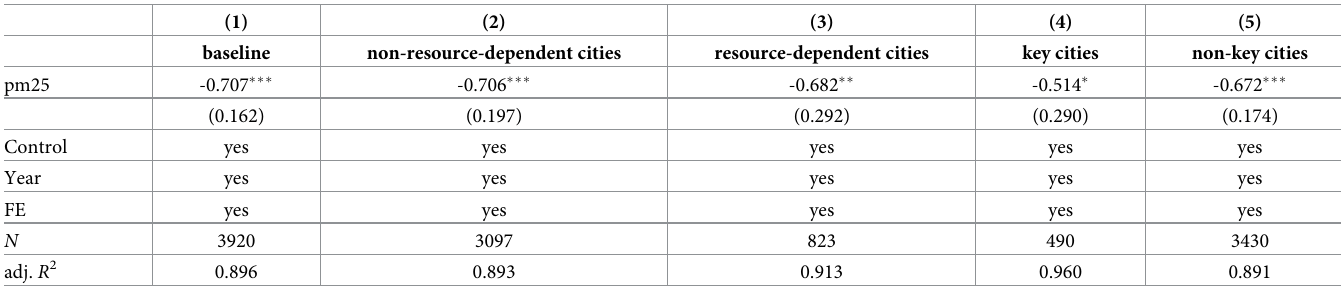
Table 4. Baseline